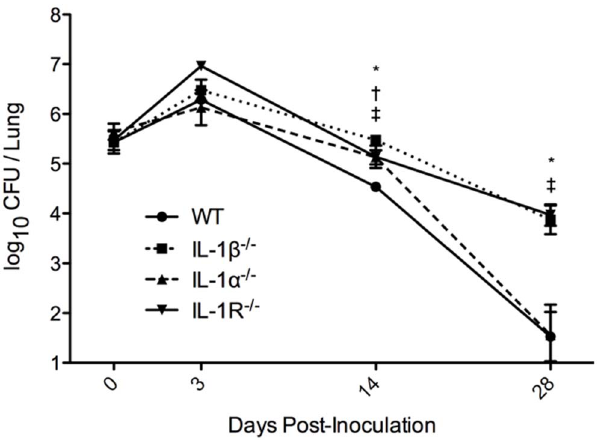
Figure 1. Bacterial clearance is mediated by IL-1 b and IL-1R but not IL-1 a . Groups of 5–8 mice were inoculated with B. pertussis (5 6 10 5 CFU) suspended in a 50 m L droplet of PBS and euthanized at indicated time points to determine bacterial CFUs in lung homogenates. The mean 6 standard error was graphed for each group at the specified time-point and is representative of three independent experiments. Significance was calculated using one-way ANOVA with Dunnet’s multiple comparison post-hoc analysis. *p , 0.05, **p , 0.01 ; WT vs IL- 1 b 2 / 2 (*), vs IL-1 a 2 / 2 ( { ), vs IL-1R 2 / 2 ( `